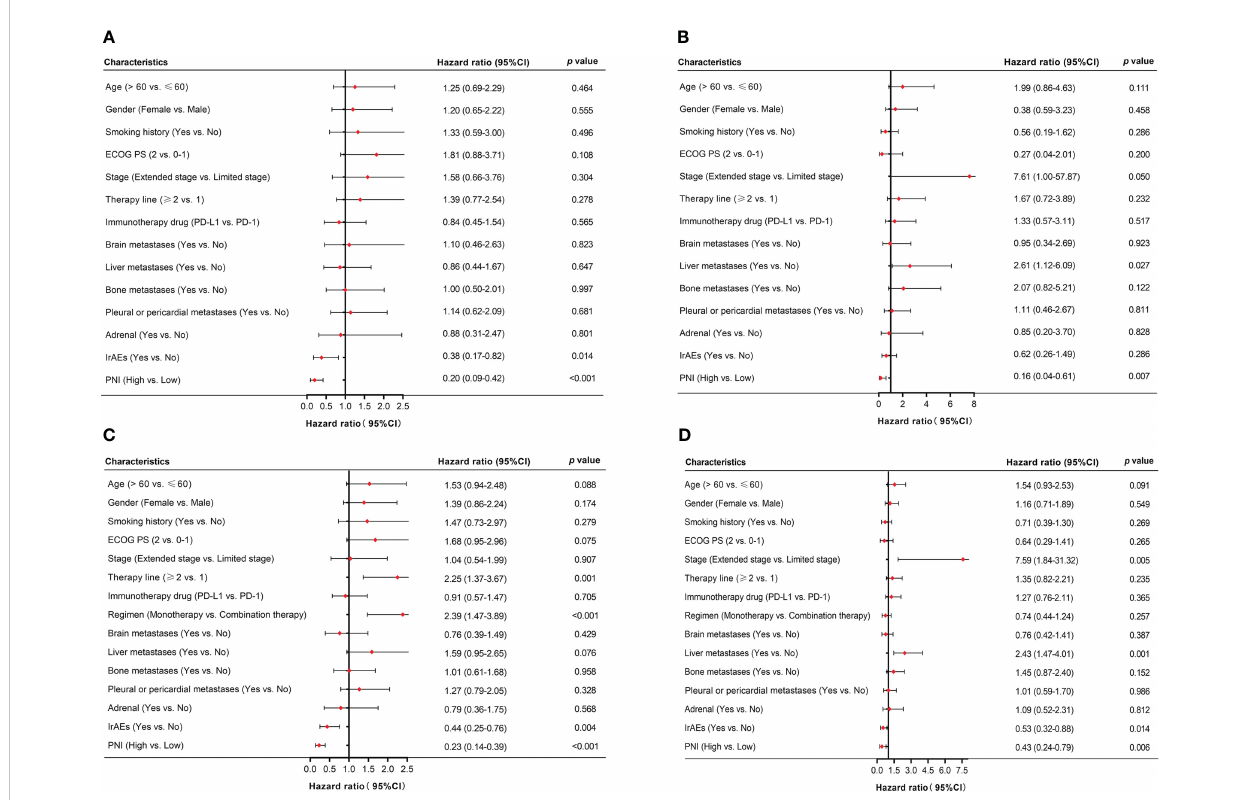
FIGURE 4 Univariate analysis of factors associated with PFS and OS in SCLC patients. (A, B) PFS and OS in SCLC patients treated with PD-L1/PD-1 inhibitors monotherapy. (C, D) PFS and OS in SCLC patients treated with PD-L1/PD-1 inhibitors combined with chemotherapy.